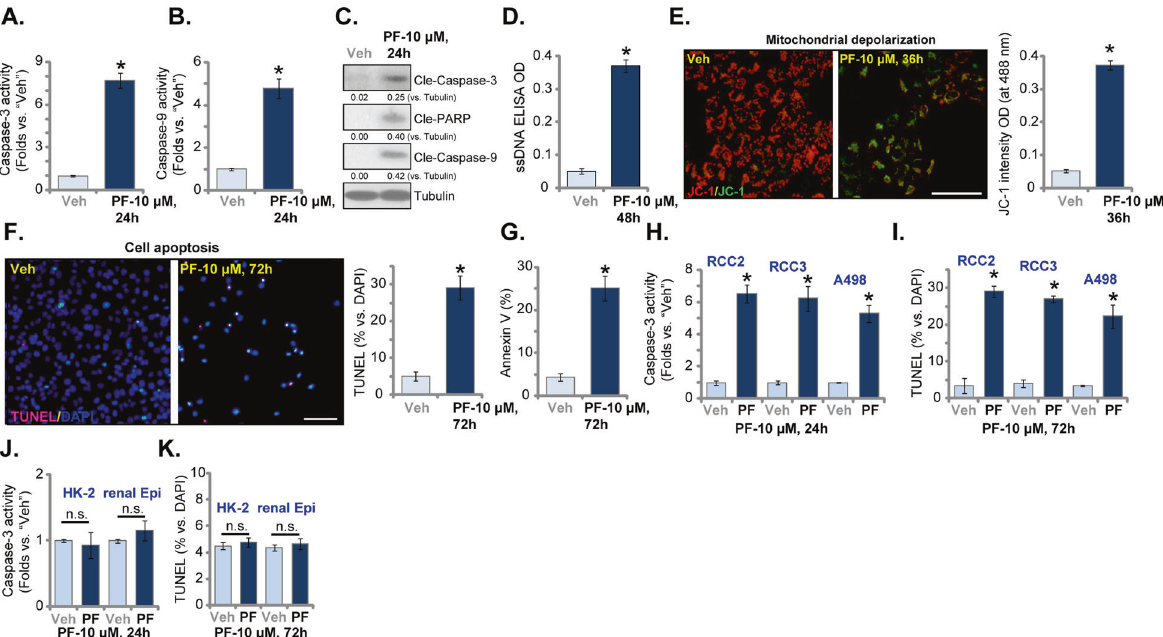
Fig. 2 PF-429242 provokes apoptosis activation in RCC cells. Primary RCC cells ( “ RCC1/RCC2/RCC3 ” , A – I ), A498 cells ( H , I ), HK-2 tubular epithelial cells ( J , K ) or the primary renal epithelial cells ( “ renal Epi ” ) ( J , K ) were treated with the applied concentration of PF-429242 and cultured for applied time periods, caspase activation ( A – C , H , and J ) and apoptosis induction ( F , G , I , and K ), DNA breaks (ssDNA ELISA OD, D ), and mitochondrial depolarization (JC-1 assay, E ) were tested by the appropriate assays mentioned in the text, and results were quanti fi ed. For each assay, n = 5. Data were expressed as the mean ± standard deviation (SD). * P < 0.05 vs. “ Veh ” group ( A – I ). “ n.s. ” stands for no statistical difference ( J , K ). In this fi gure, experiments were repeated three times, and similar results were obtained each time. Scale bar = 100 μ m ( E , F